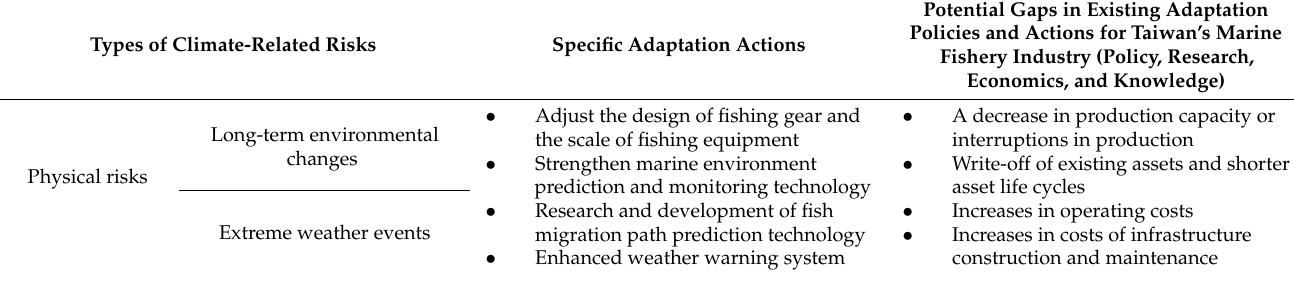
Table 5. Potential gaps and impacts of current adaptation actions in the marine fishery industry in response to climate